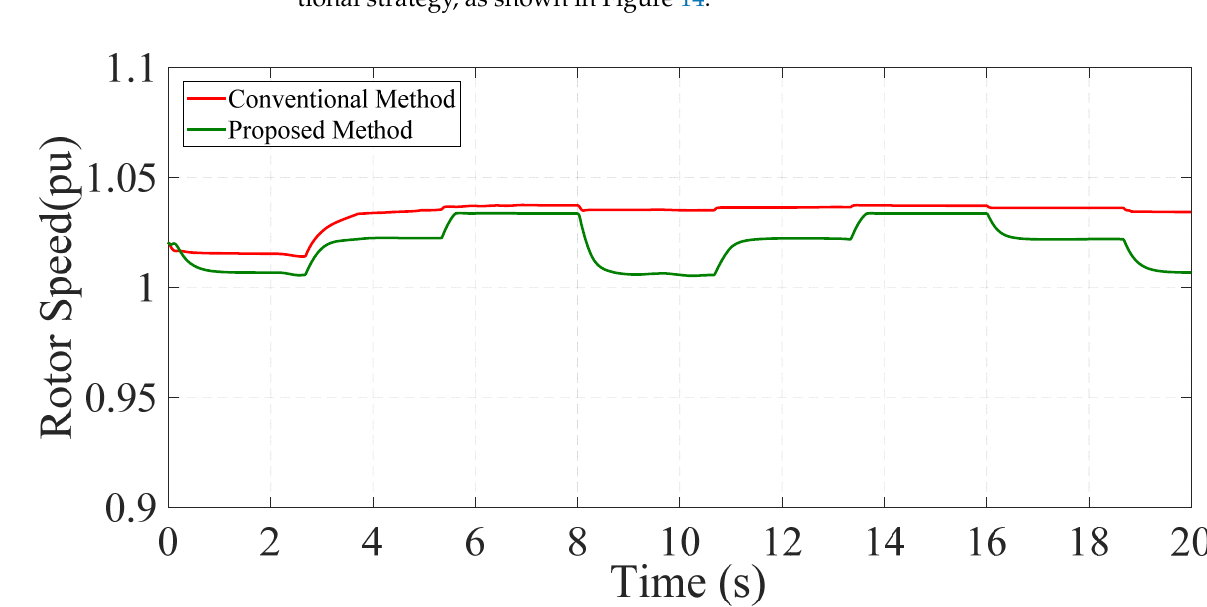
Figure 13. Comparison between the generator speed in the proposed system and the conventional method.